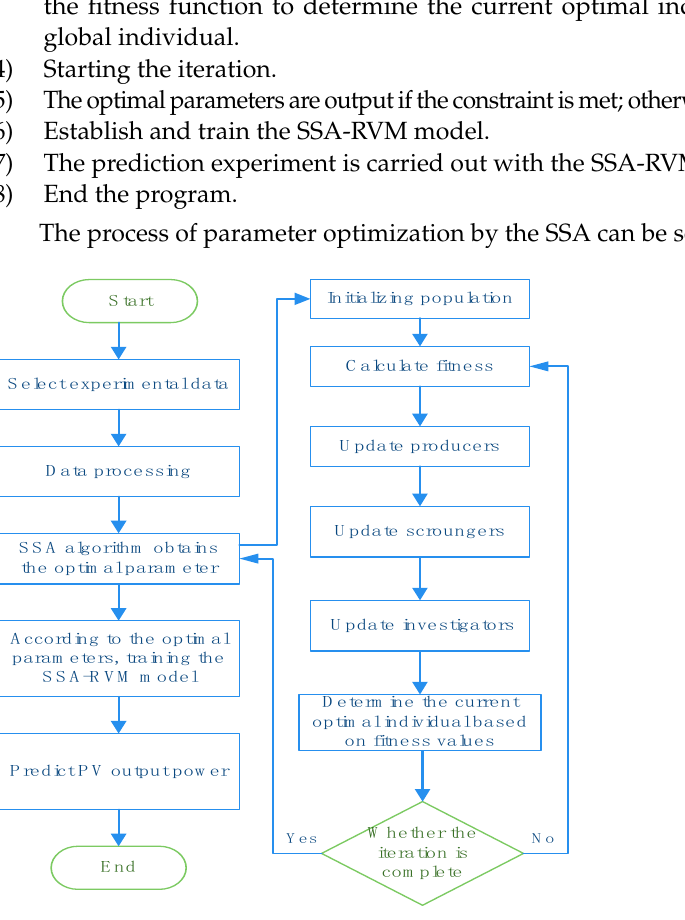
Figure 2. Flow chart of parameter optimization with